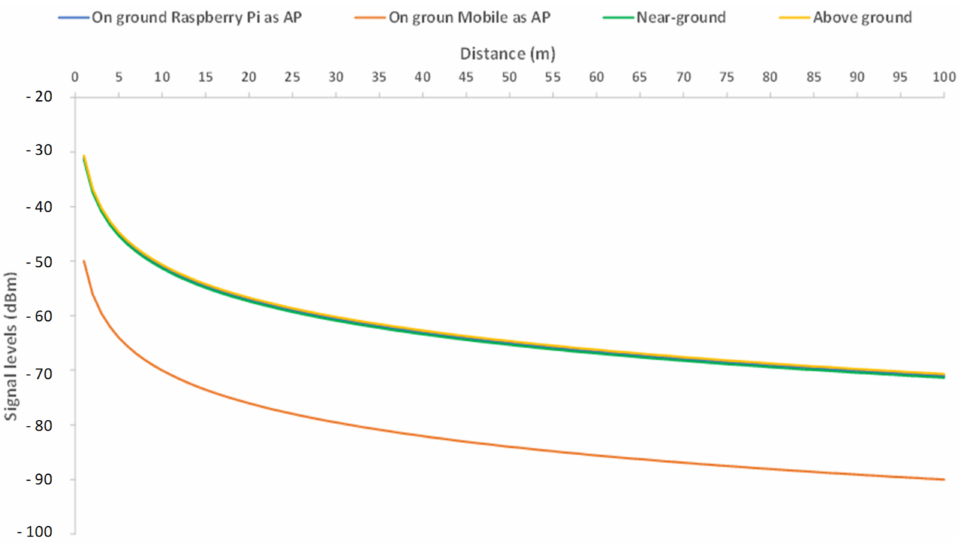
Figure 4. Signal levels under rainfall